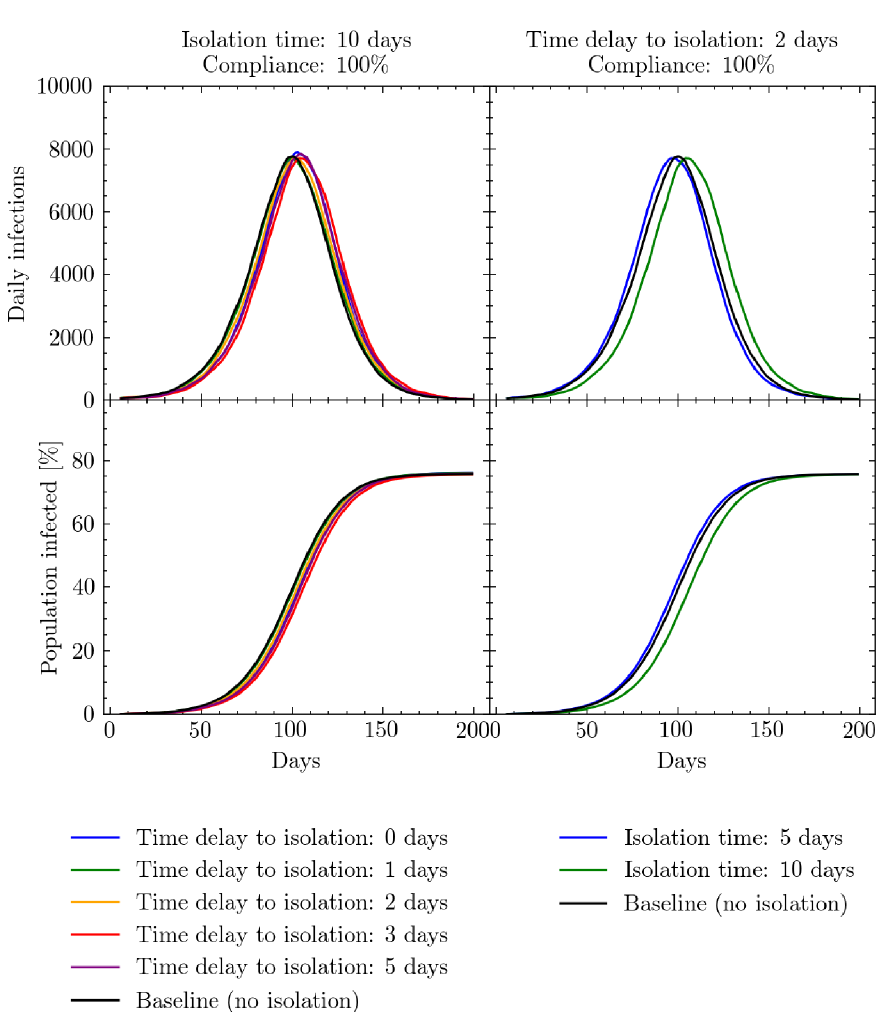
Fig 6. Isolation center simulation results. Simulated daily (7-day rolling average) and cumulative infections measured in days since the beginning of the simulation. Left: the effects of varying the mean time delay to attend an isolation and treatment center from symptom onset relative to the baseline home-care scenario while time spent in the isolation and treatment center is fixed at 10 days. Right: the effects of varying the time spent in an isolation and treatment center while keeping the mean time delay to the center fixed at 2 days. In both scenarios the compliance rate that people present themselves for isolation is set too 100%. See S1 Table for a presentation of the cumulative number of infections, peak intensity and peak timings for these